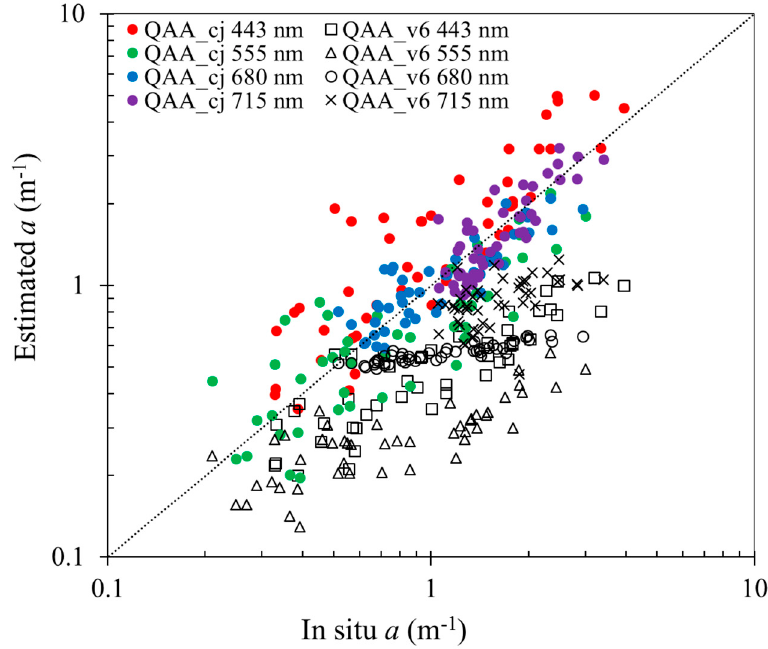
Figure 7. Comparison of in situ and predicted a ( λ ) at 443, 555, 680 and 715 nm based on an in situ data set collected from the Changjiang estuarine and coastal waters. The filled circles and empty symbols denote retrievals from algorithms QAA_cj and QAA_v6, respectively.